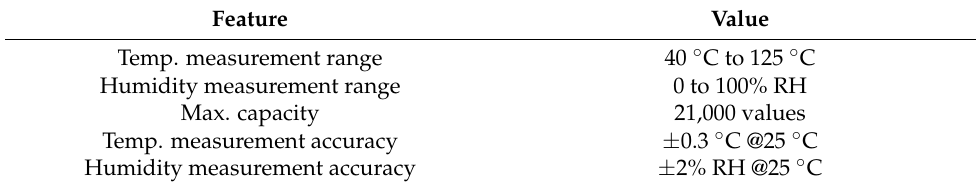
Table 1. Main characteristics of the data-loggers.